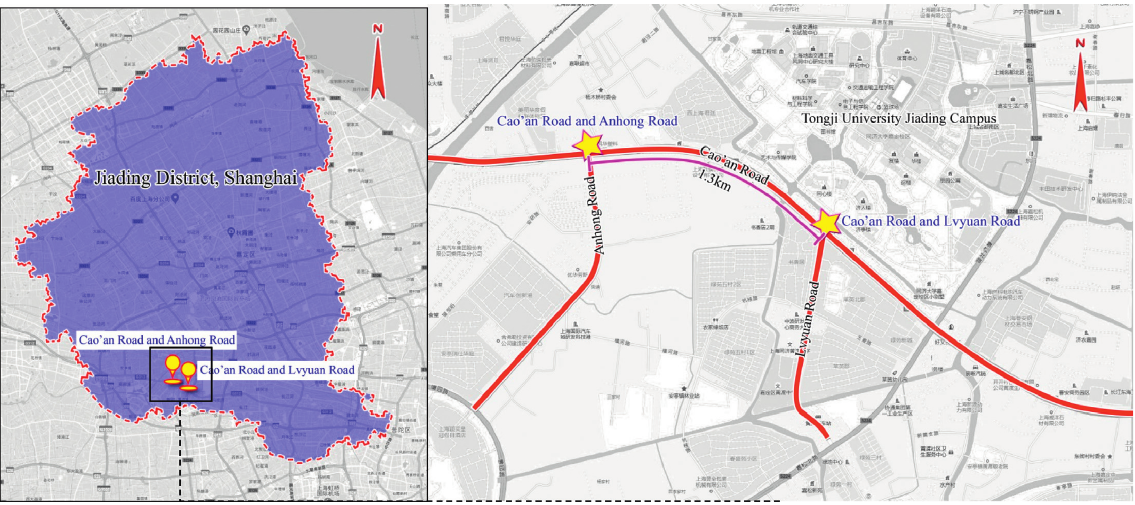
Figure 1: Location of the observed intersections in Shanghai. Table 1: Key parameters of the observed